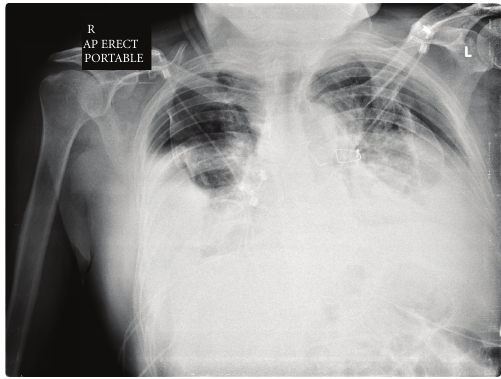
Figure 1: CXR showing bilateral pneumothoraces with displaced sternal wires.